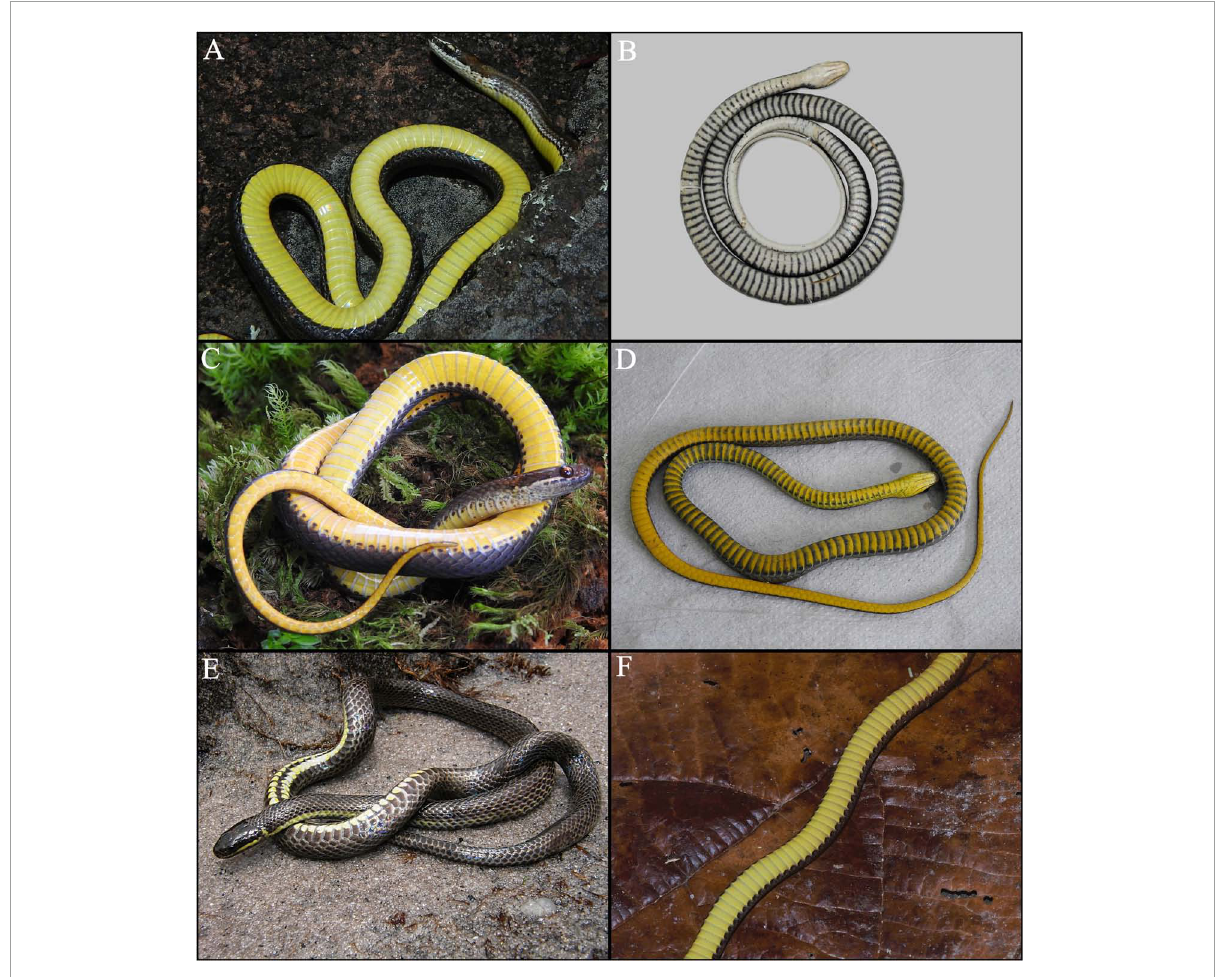
FIGURE7 Comparative midventral pattern in Echinantherini. (A) Adelphostigma cf. occipitalis ; (B) Amnisiophis amoenus ; (C) Dibernardia persimilis ; (D) Echinanthera cephalostriata ; (E) Sordellina punctata ; and (F) Taeniophallus nicagus